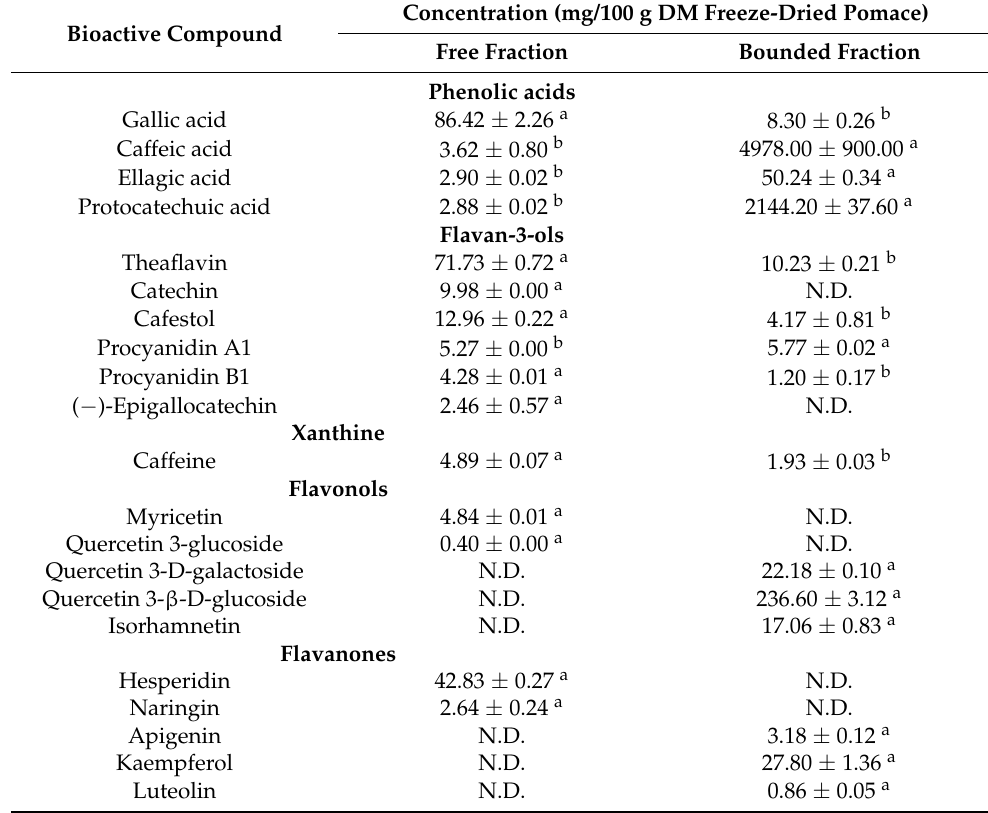
Table 1. The free and bounded phenolic compounds in freeze-dried apple